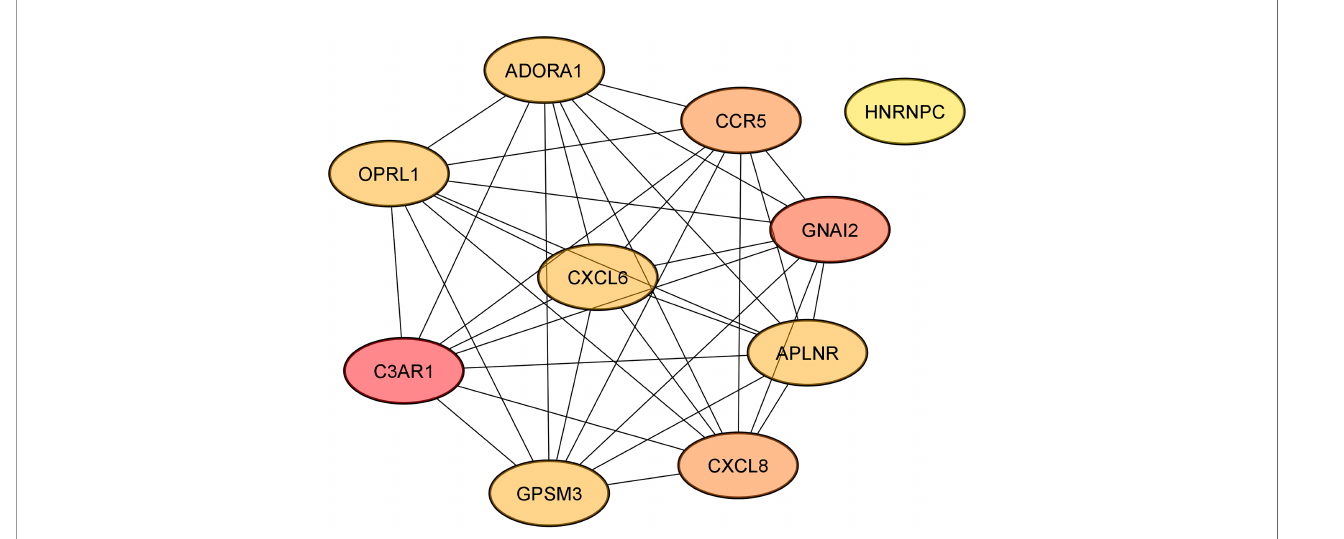
FIGURE 4 | The networks of the top 10 hub